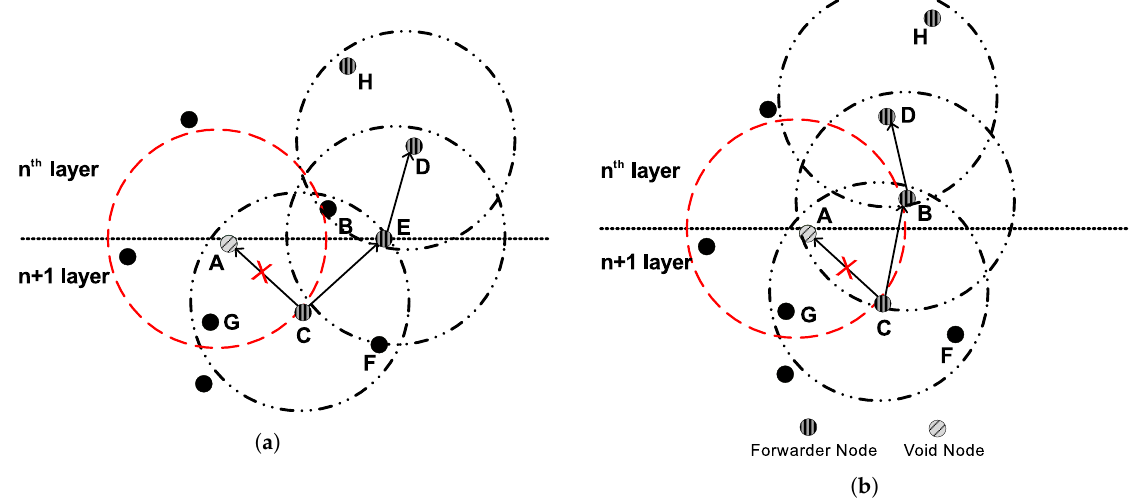
Figure 4. Forwarder Node Selection in FLMPC-One. ( a ) Cross Node potential forwarder node (PFN); ( b ) Relay Node PFN.